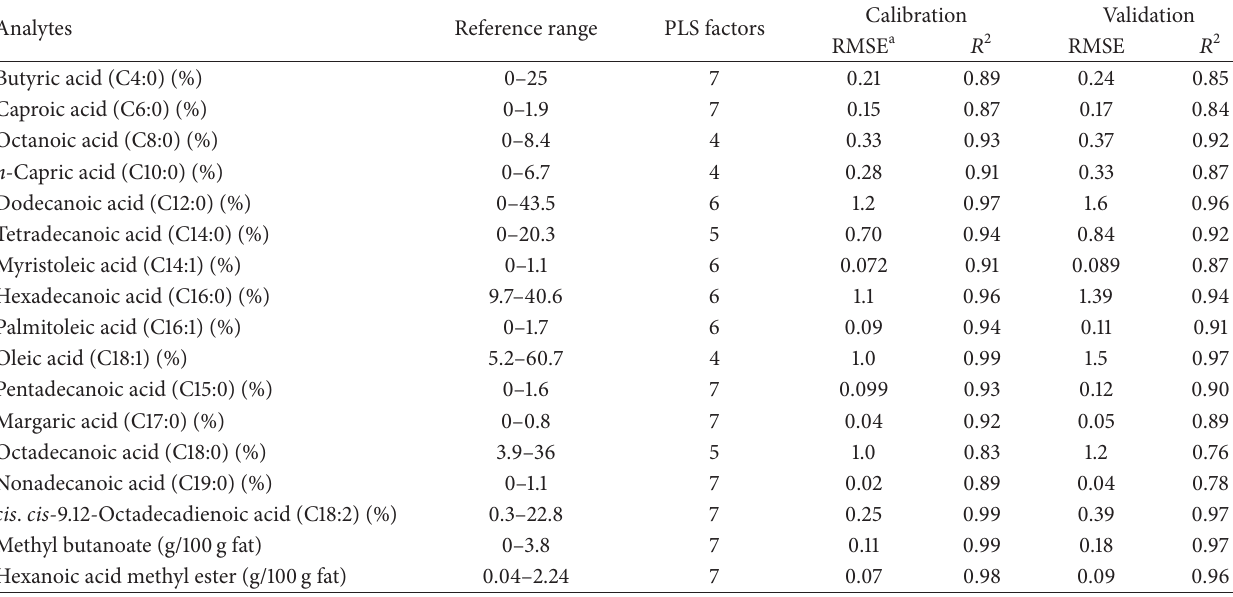
Table 1: PLS correlation between data of reference GC analysis and NMR spectra (6.0–0.25 ppm) for ice cream ( 𝑛 =